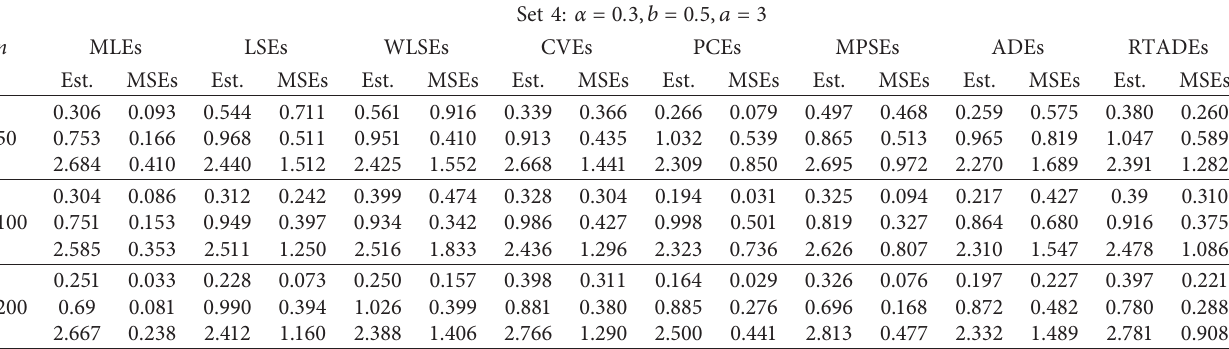
Table 4: Estimates and MSEs of APTIL distribution for ML, LS, WLS, CV, PC, MPS, AD, and RTAD estimates for set 4.